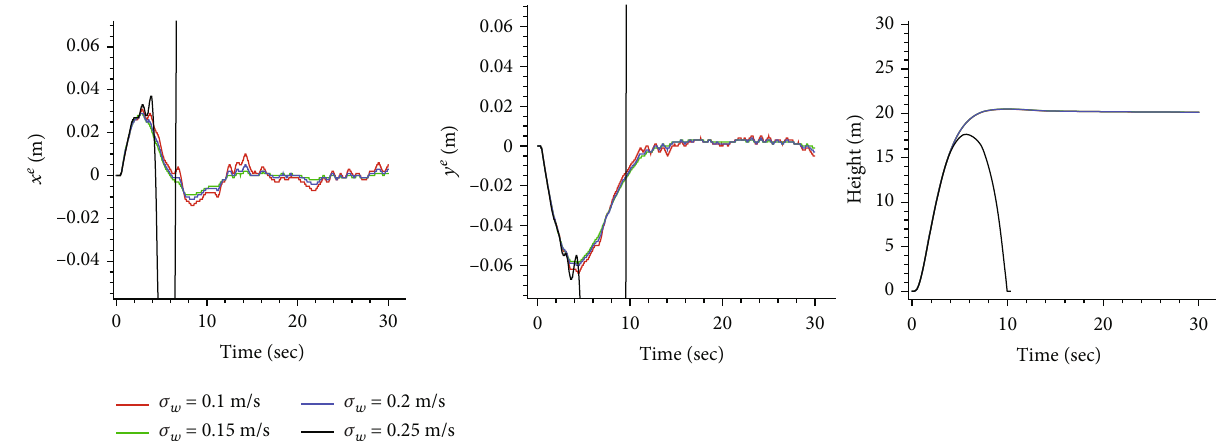
Figure 28: Position response of Quad-Plane under the Von Karman wind disturbance.